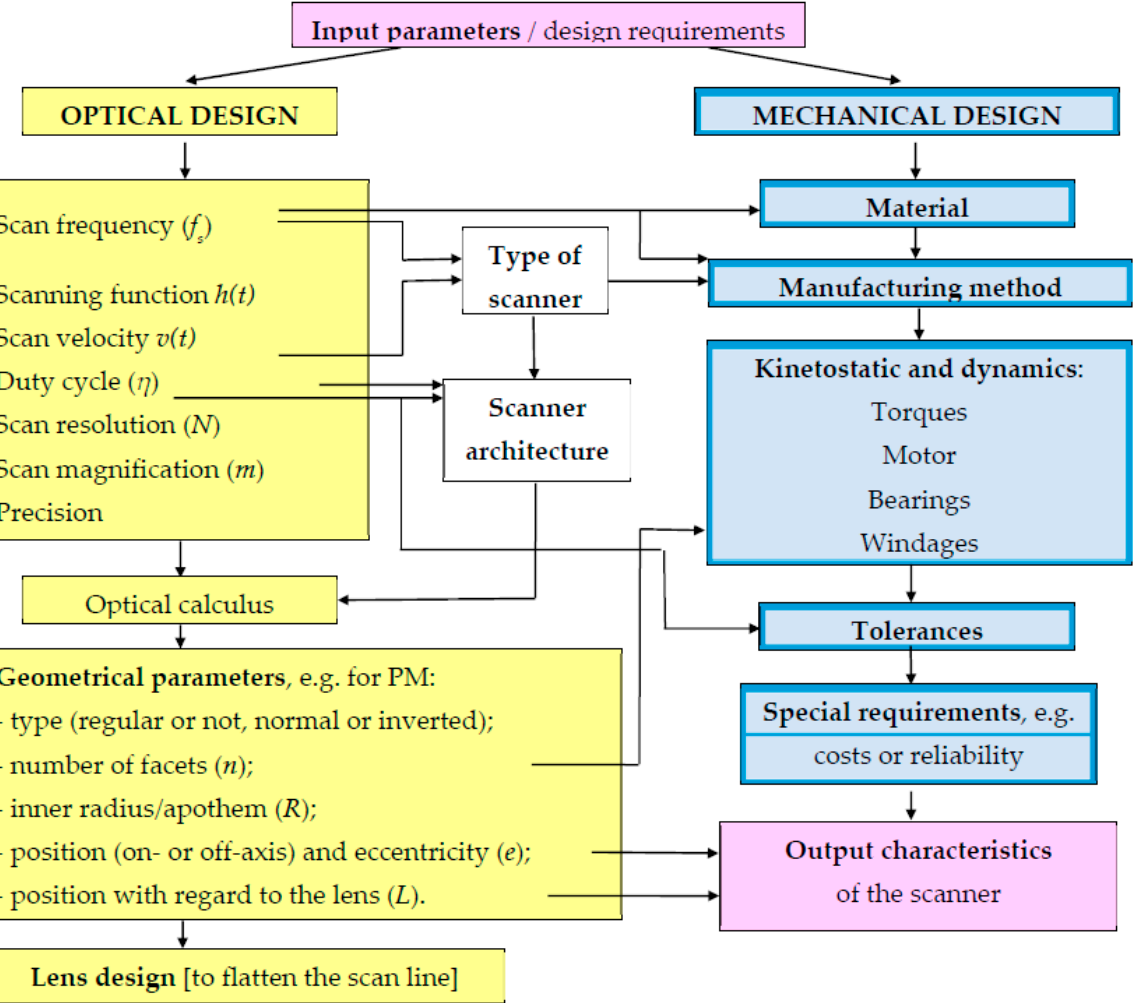
Figure 17. Optomechanical designing scheme of PM scanning heads connecting optical and mechanical aspects.